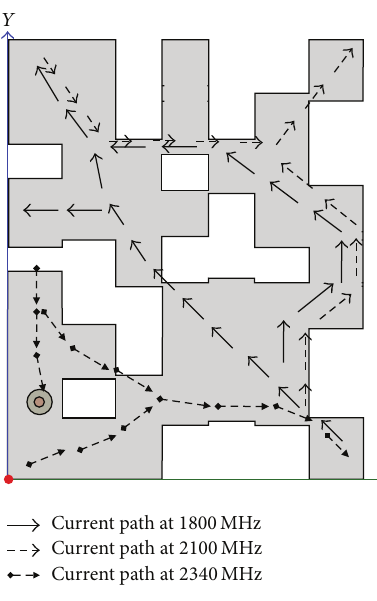
consists of combination of different overlap sizes, resulting in a larger bandwidth from 1710 MHz to 2500 MHz (Figure 5).